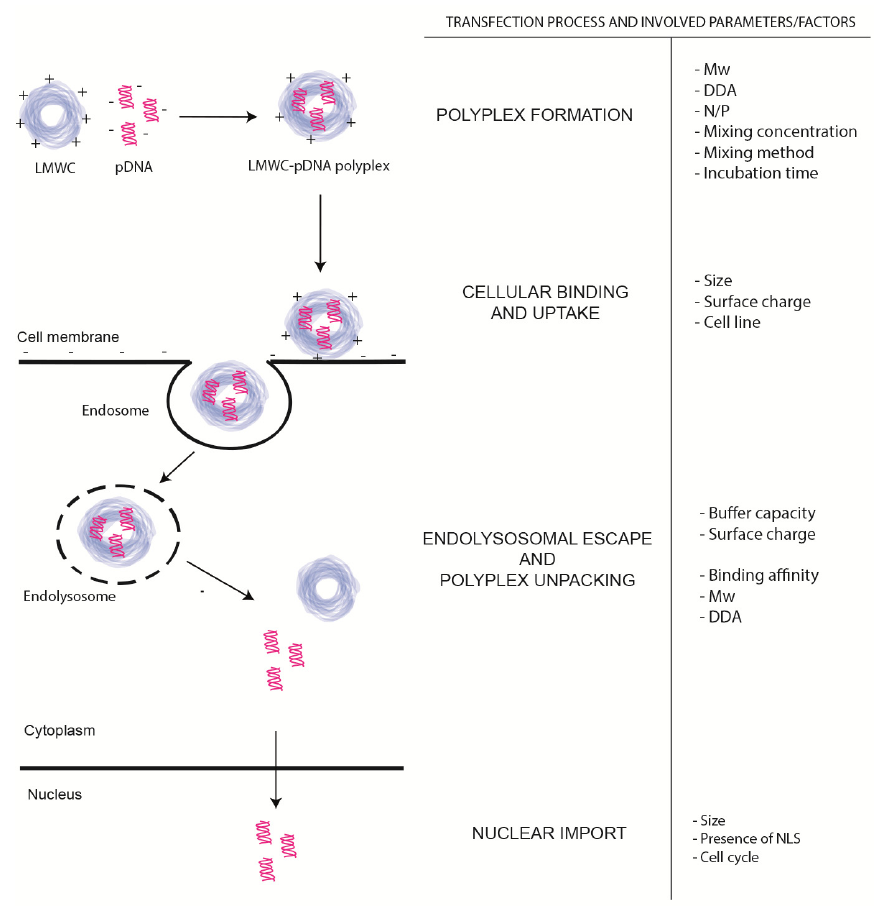
Figure 6. Schematic representation of the transfection process and the parameters/factors involved in each